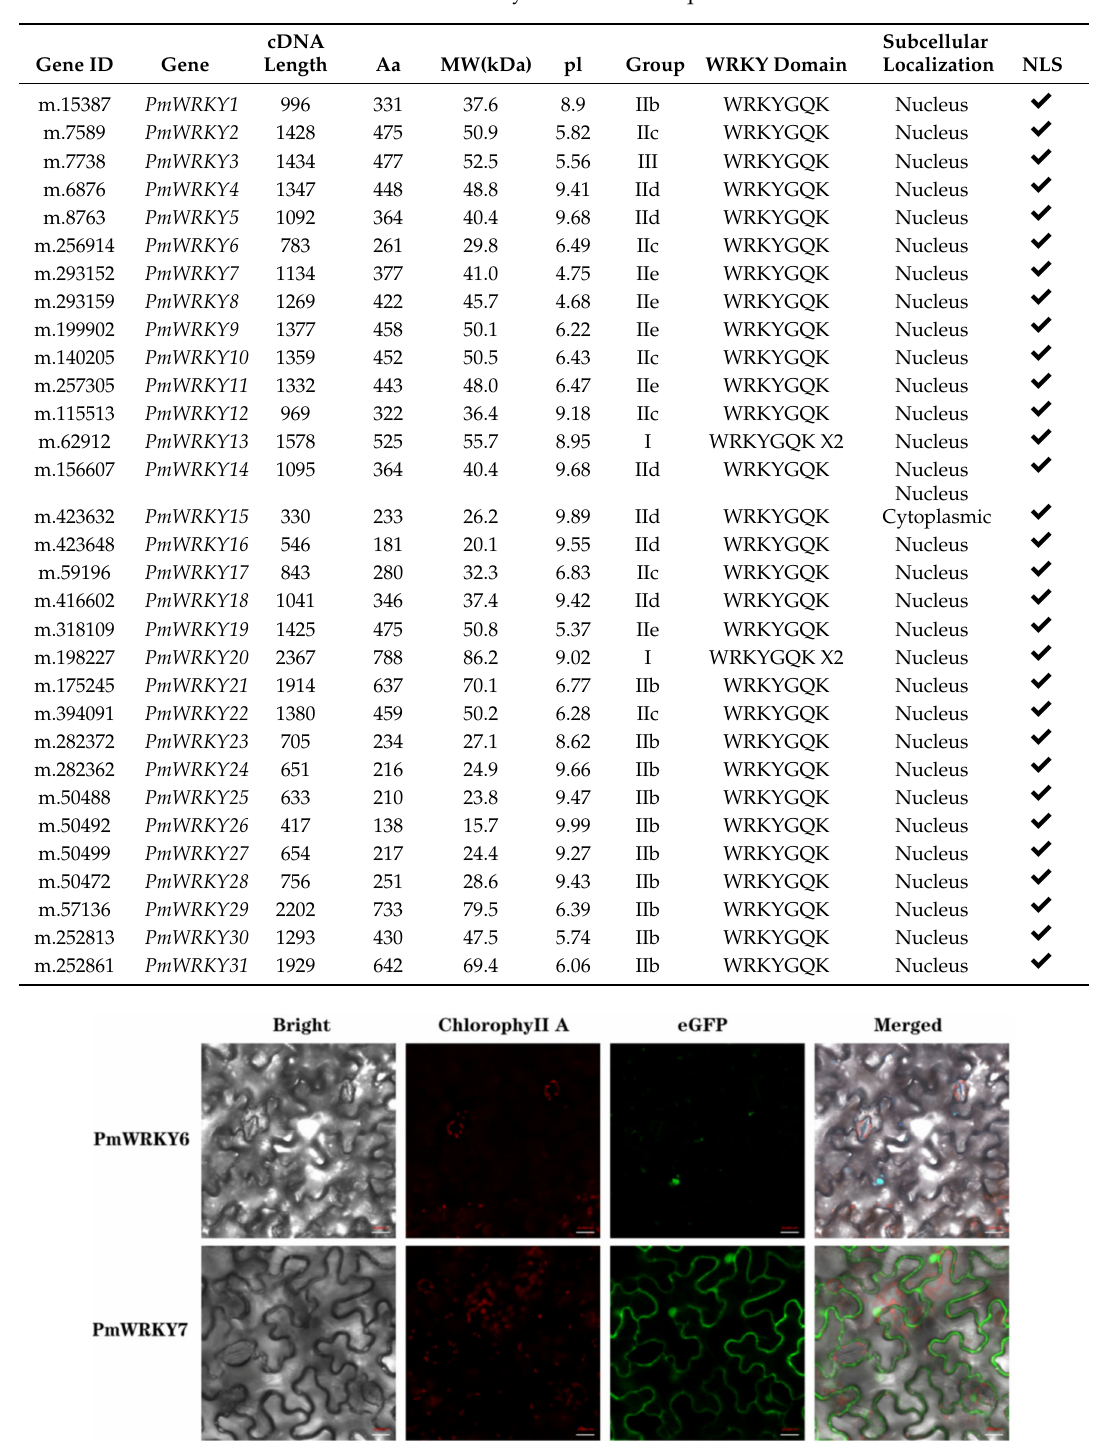
Table 1. Summary of PmWRKY Sequences.